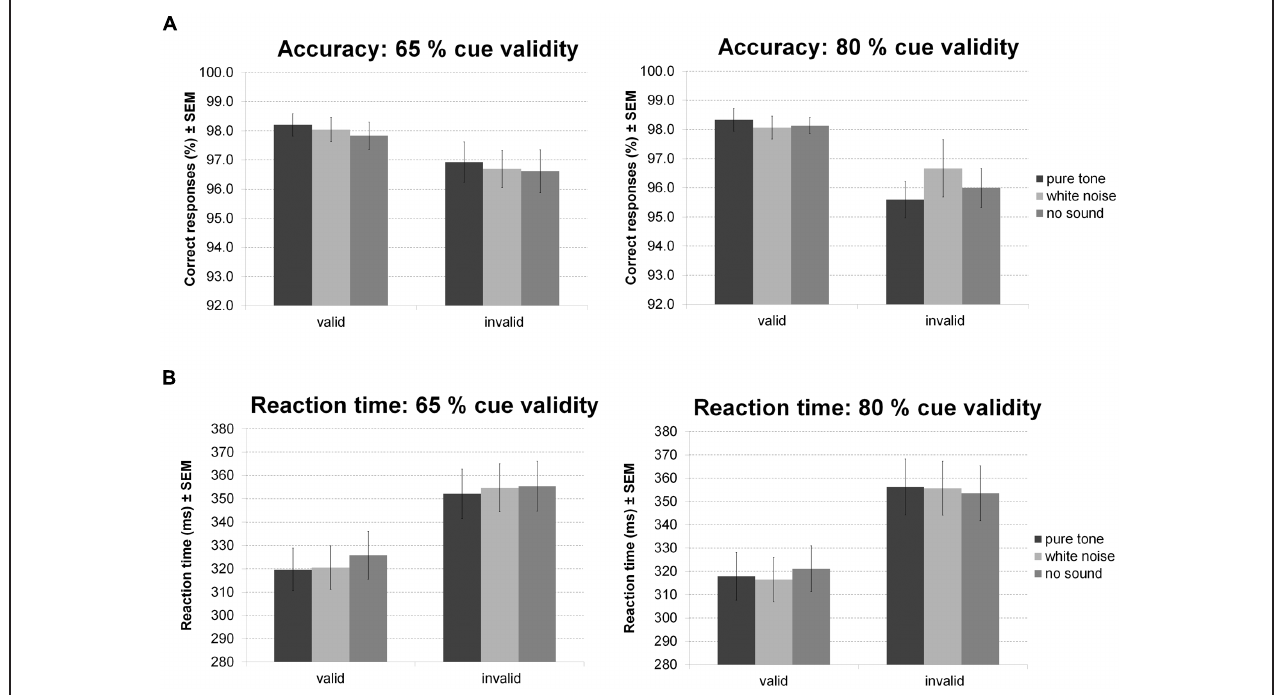
FIGURE 9 | Posner task. The figure depicts mean accuracy (A) and mean RT (B) together with the standard error of the mean (SEM) by sound condition, validity, and probability in Experiment 5.